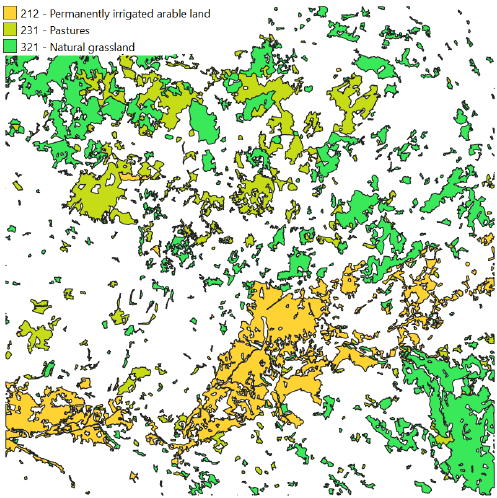
Figure 2. Spain: distribution of LC classes.